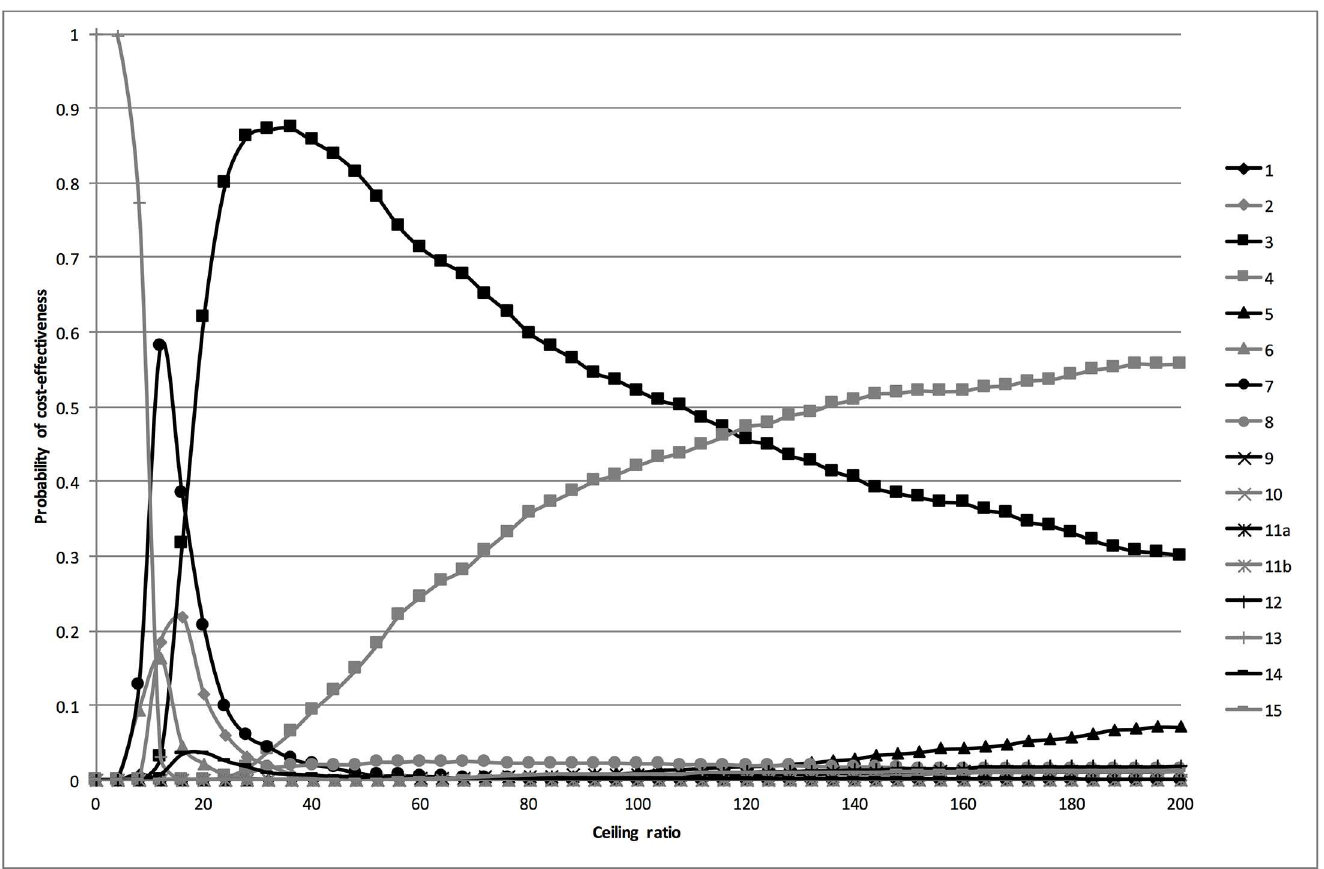
Fig 2. Cost-effectivenessacceptability curves for the main analysis. The cost-effectiveness acceptability curves are based on the probabilistic analysis.They show the probabilitythat the different diagnosticstrategies are cost-effective at a range of ceilingratios.